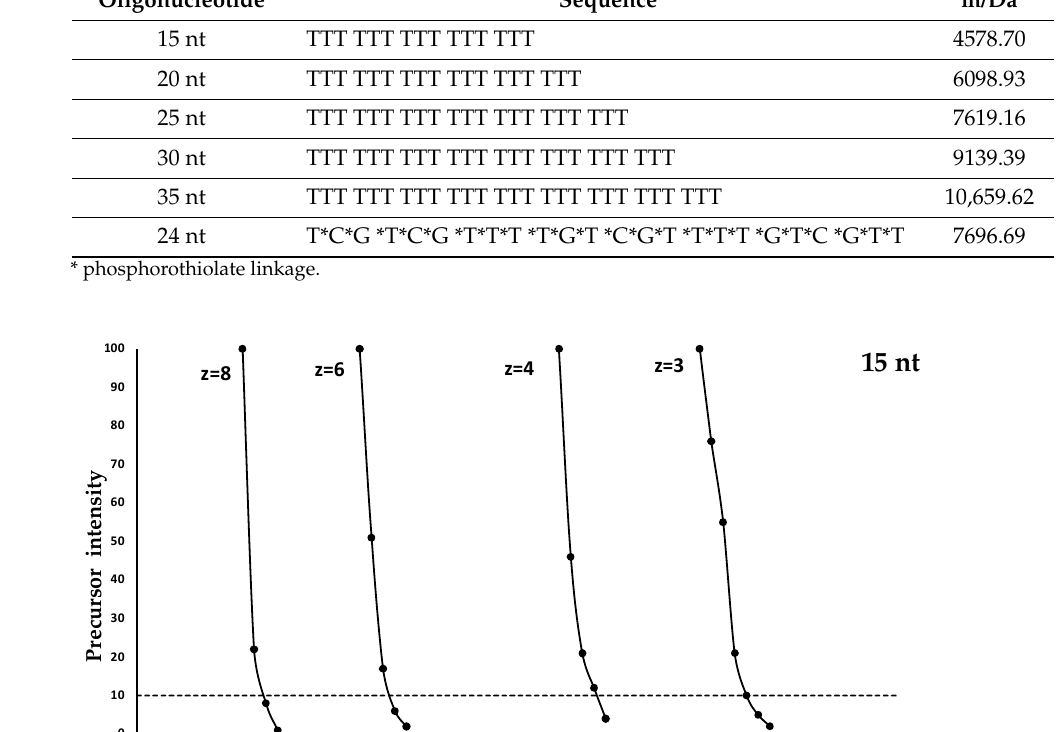
Table 1. Sequence and mass of used oligonucleotides.